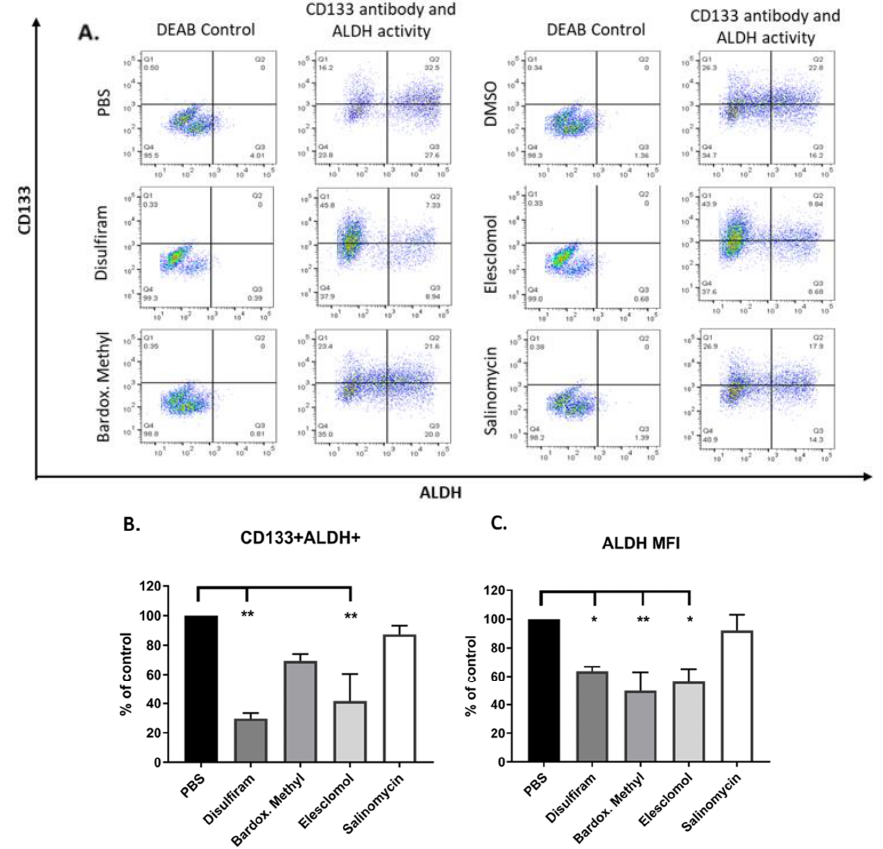
Figure 4. Expression of cancer stem cell markers ALDH activity and CD133 expression in OV90. ( A ) CD133 + ALDH high populations of cells grown under TIC-enriching conditions after 72 h exposure to the drugs at LD50 concentrations or PBS control. ( B ) Quantified values of the CD133 + ALDH high double positive population expressed as percentage of control (PBS). ( C ) Quantified geometric mean intensity of ALDH in CD133 + ALDH high populations, expressed as percentage of control (PBS). Graphs represent mean and SEM of each treatment, indicated by grayscale shaded bars, * p < 0.05, ** p < 0.01. 2.5. Candidate Drugs Enhance the Oxidative Stress of Cells Grown in TIC-Enriching Spheroid Conditions